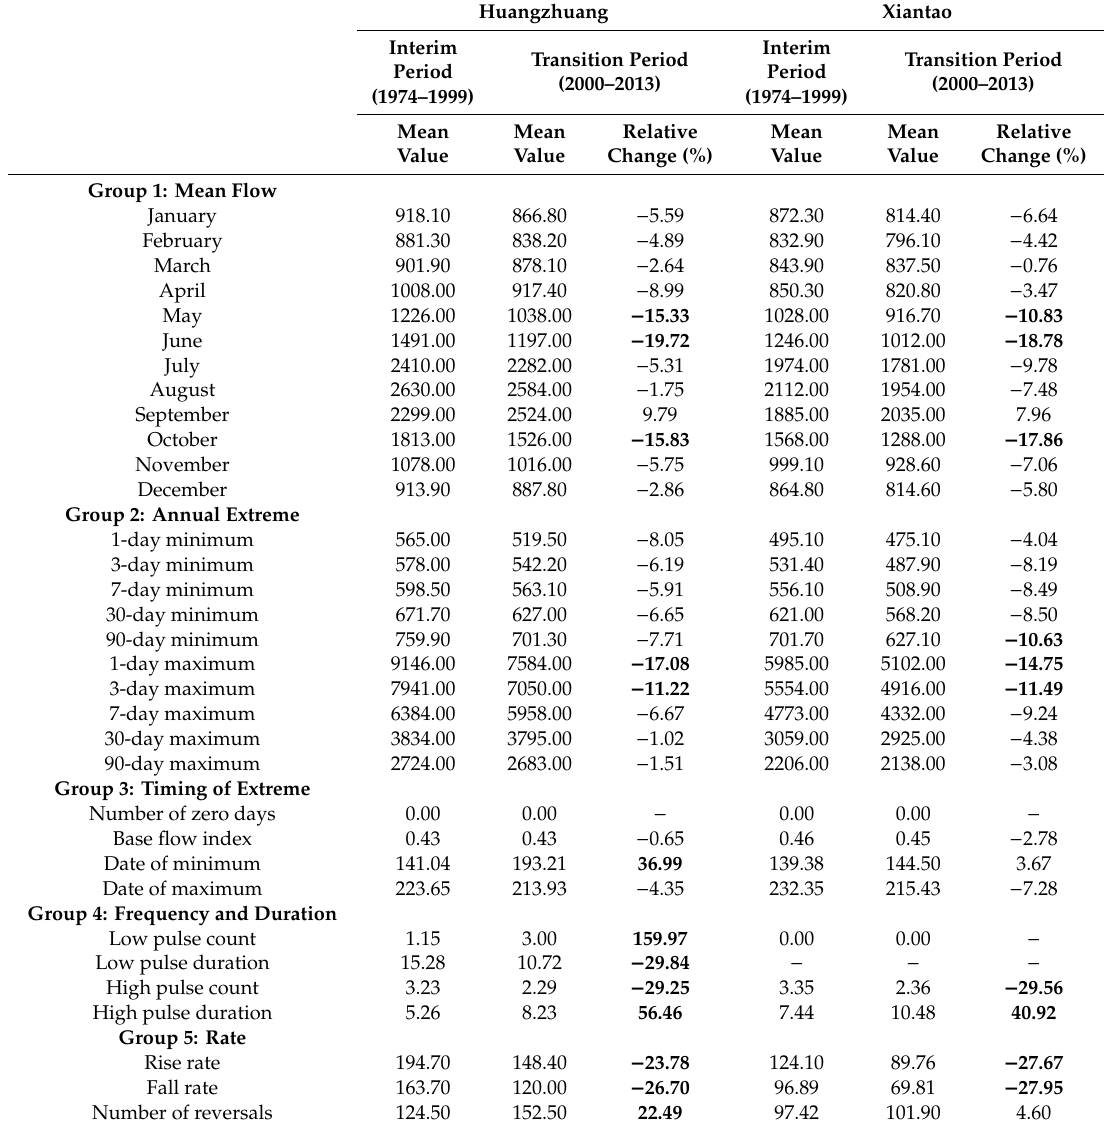
Table 4. Changes of IHA metrics in the transition